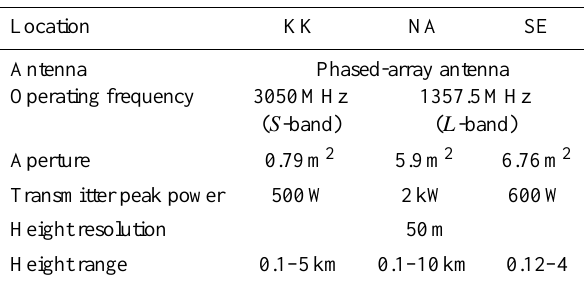
Table 1. Specifications of the S - and L -band WP.